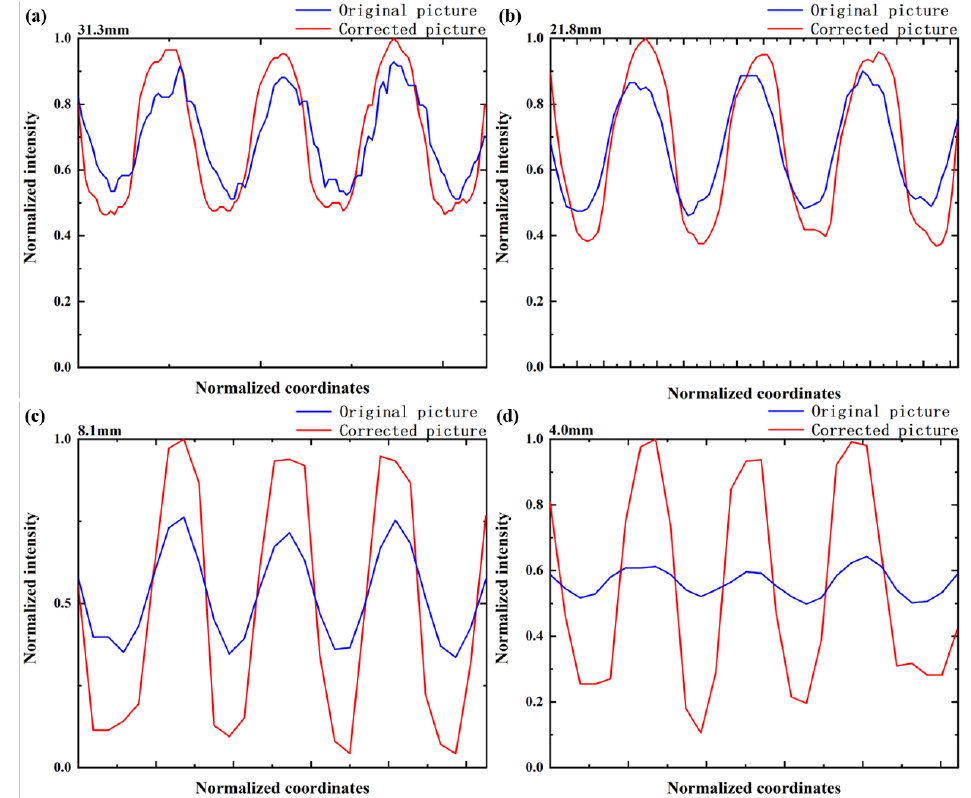
Figure 7. Normalized intensity before and after image processing with different focal lengths. The blue line is the normalized intensity of the original image, and the red line is the normalized intensity of the image after image processing. ( a ) f = 31.3 mm. ( b ) f = 21.8 mm. ( c ) f = 8.1 mm. ( d ) f = 4.0 mm.